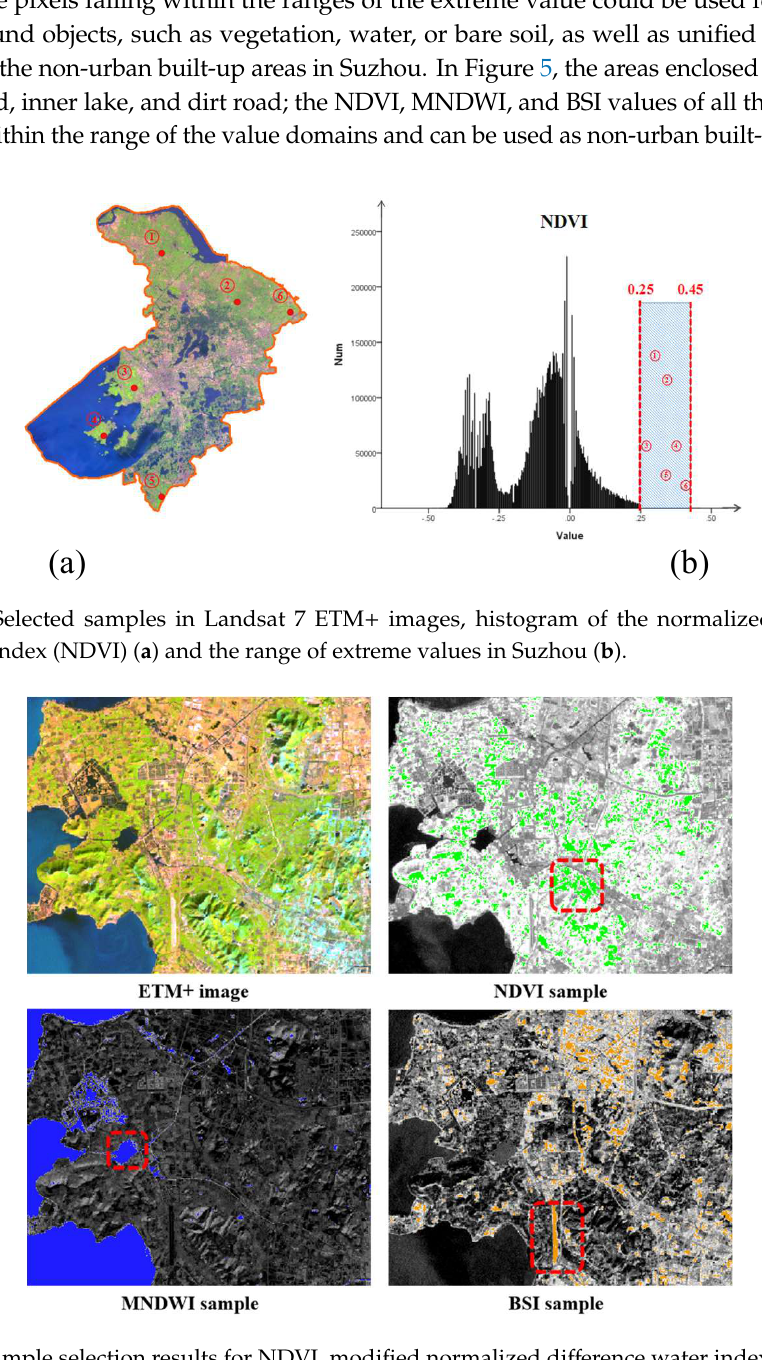
Figure 5. Sample selection results for NDVI, modified normalized difference water index (MNDWI), and bare soil index (BSI) in Suzhou: ( a ) a false color composite of the ETM+ image; ( b ) candidate NDVI samples; ( c ) candidate MNDWI samples; ( d ) candidate BSI samples.